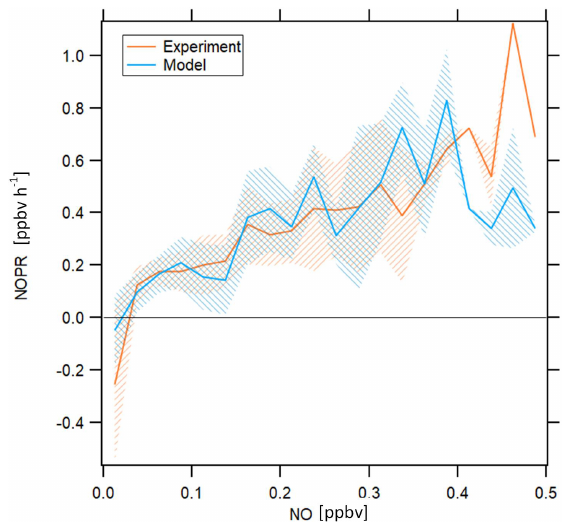
Figure 7. NOPRs derived from measured and simulated data as a function of NO mixing ratios. The orange and blue lines represent average profiles calculated based on measured and simulated data, respectively. The blue and orange shading represent ± 1 standard deviations of the average lines. The profiles have been filtered for stratospheric measurements by removing data points for which O 3 exceeds